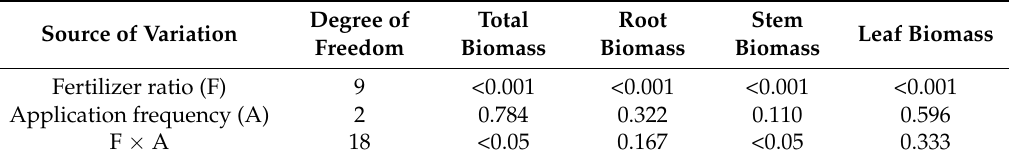
Table 6. The p values of the main effects of Fertilizer ratio (F), Application frequency (A) and their interactions on total biomass, root biomass, stem biomass and leaf biomass of M. wufengensis seedlings. Degree of Total Root Stem Leaf Biomass Source of Variation Freedom Biomass Biomass Biomass Fertilizer ratio (F) <0.001 <0.001 <0.001 <0.001